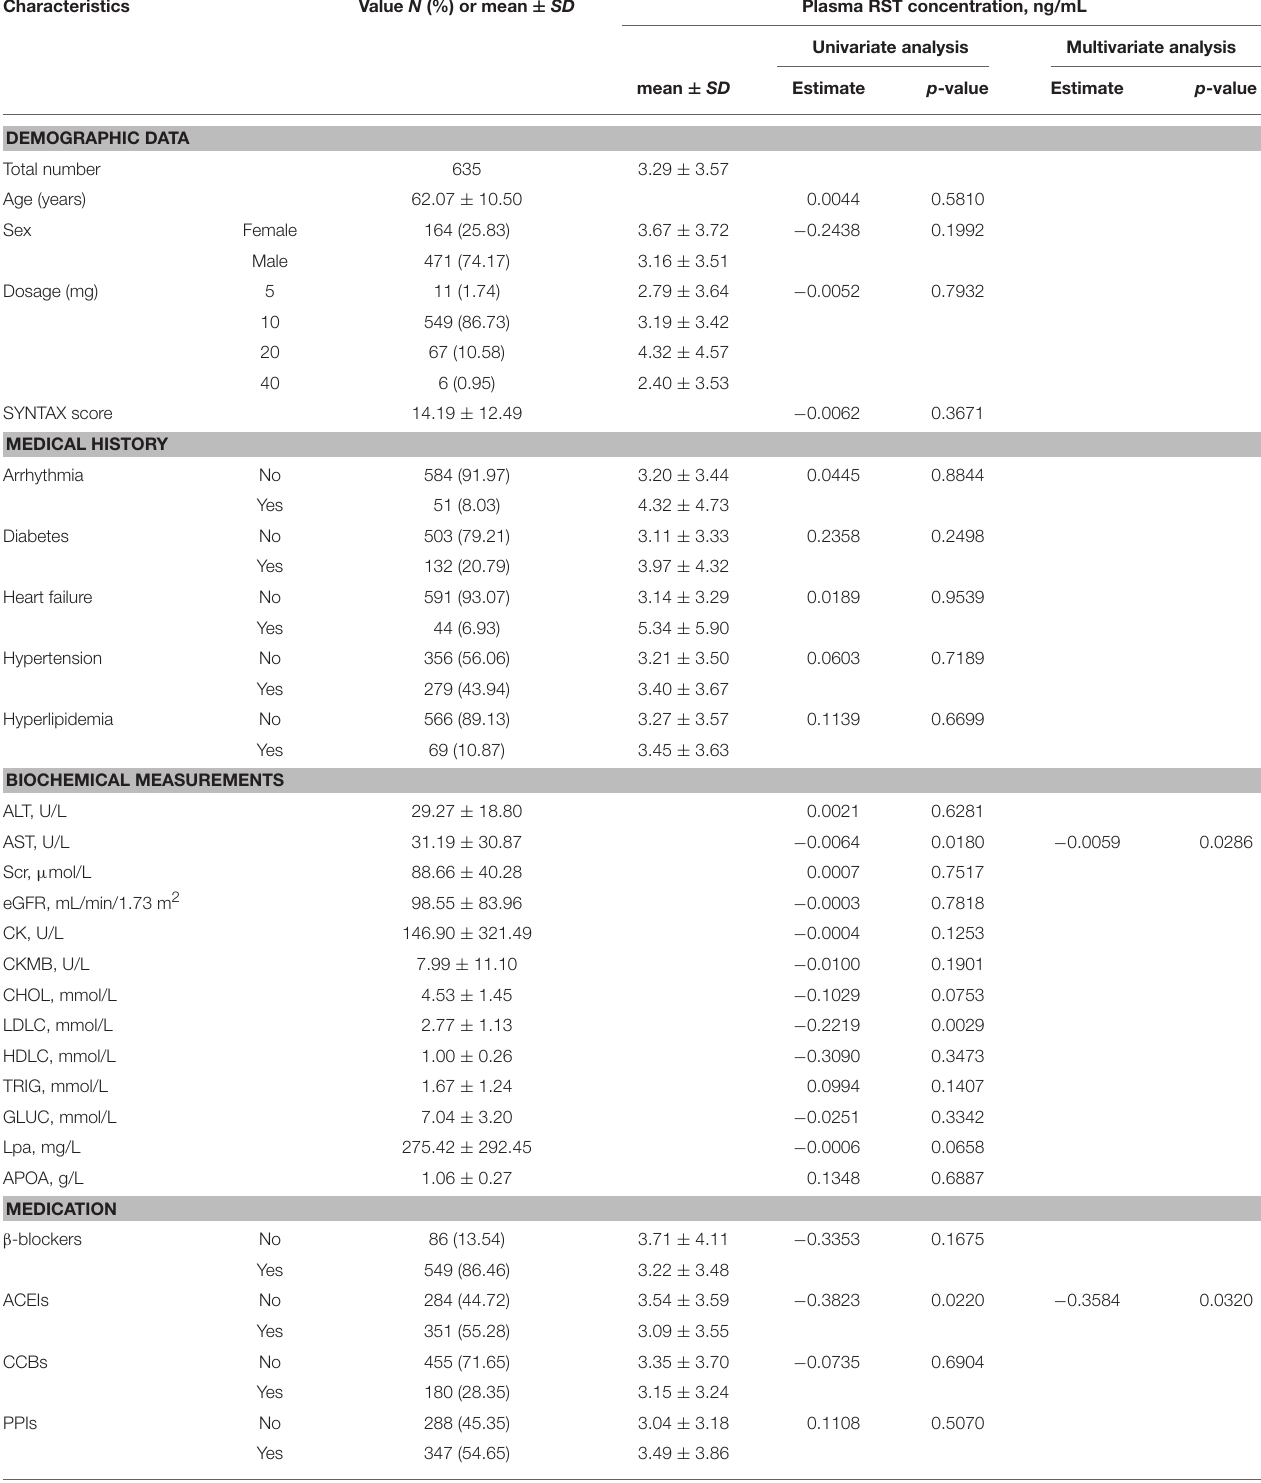
TABLE 2 | Patient characteristics and their effects on plasma concentration of RST.